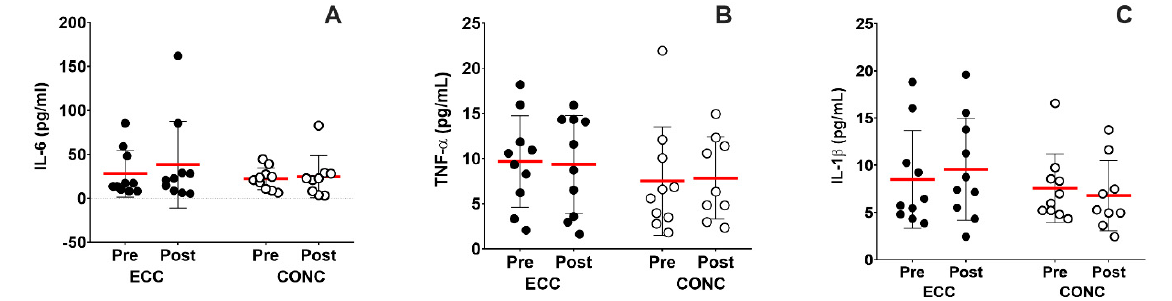
Figure 4. Concentration of systemic inflammation markers. Interleukin 6 (IL-6) ( A ), tumor necrosis factor α (TNF- α ) ( B ), and interleukin 1 (IL-1) ( C ) concentrations. ECC: eccentric cycling, CONC: concentric cycling.